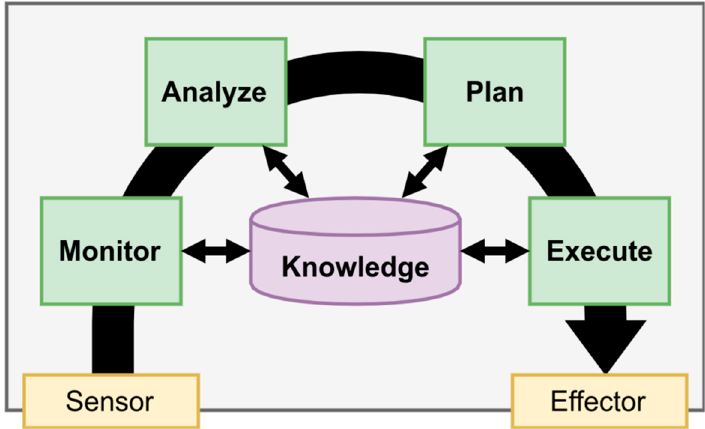
Figure 3. Functional description of a MAPE-K autonomic manager implementing the MAPE-K loop.